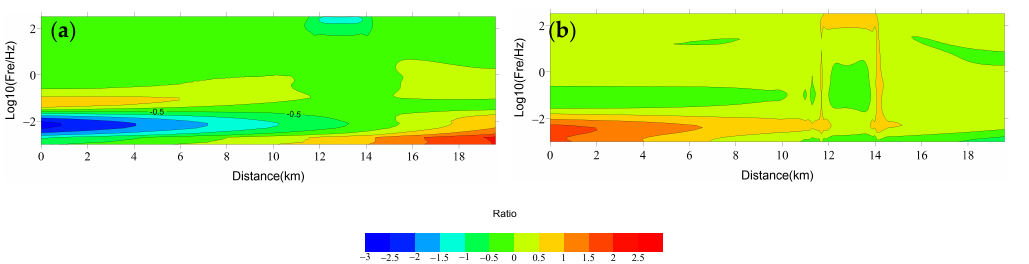
Figure 2. 2D comparison of apparent-resistivity sections of TE (upper) and TM (lower) mode by different forward-methods. ( a , c ) are calculated using the FD method; ( b , d ) are calculated using the FE method.